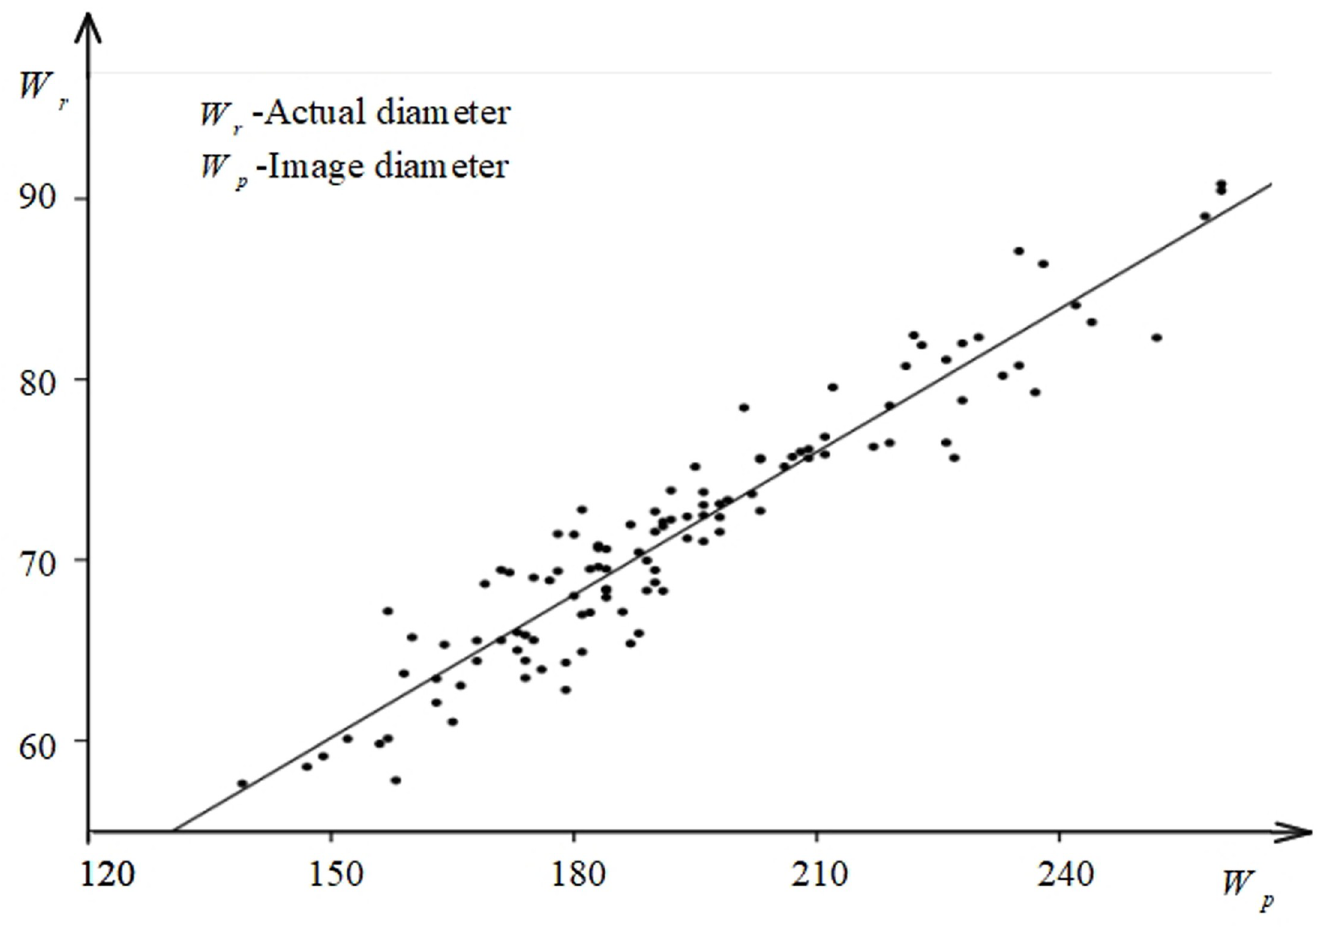
Fig 5. Linear regression model of tomato size.